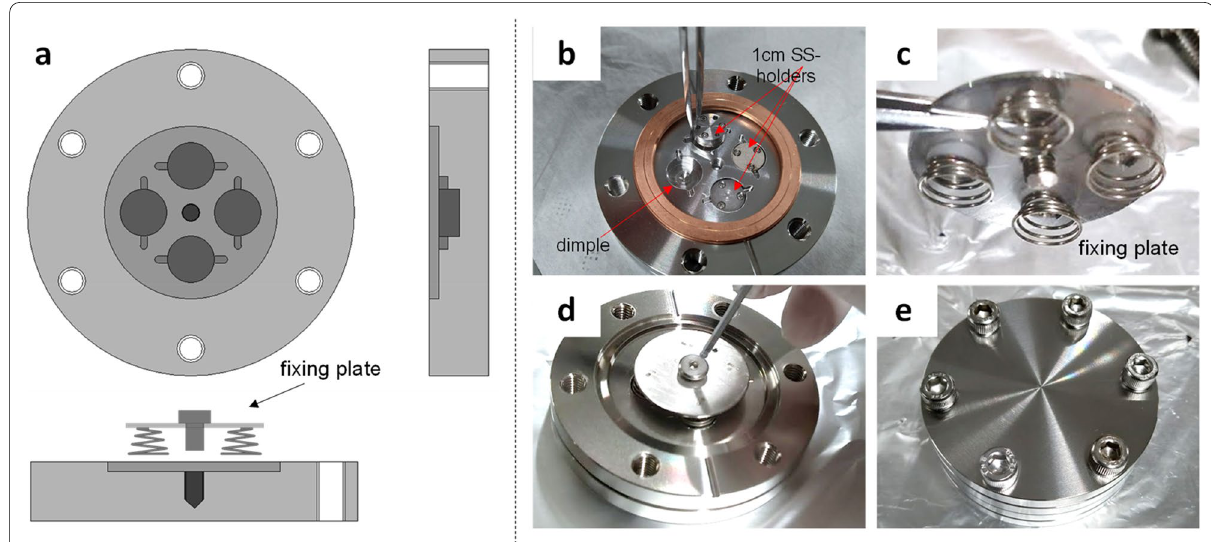
Fig. 7 Schematic diagram and photographs of the transportation container. a . The container was made from a ConFlat (CF) vacuum flange. b . Four 1 cm SS- holders can be stored in the dimples. c . The 1 cm SS-holders were fixed using the fixing plate. d . The fixing plate can be fastened × with one hand, e . The container was sealed using the other CF flange and a Cu metal gasket with a torque of 5 N